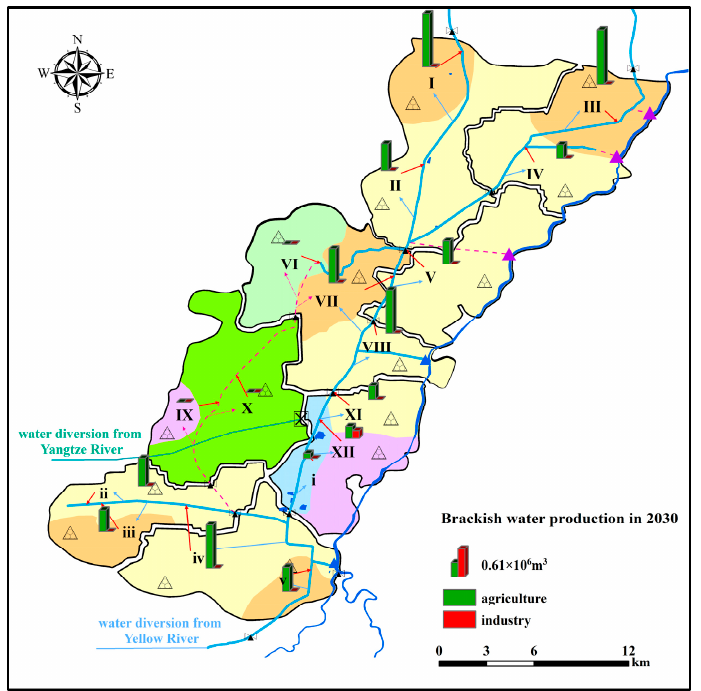
Figure 11. Brackish water configuration in 2030 under the second scenario, reduces soil salinization and improves the soil ecological environment.